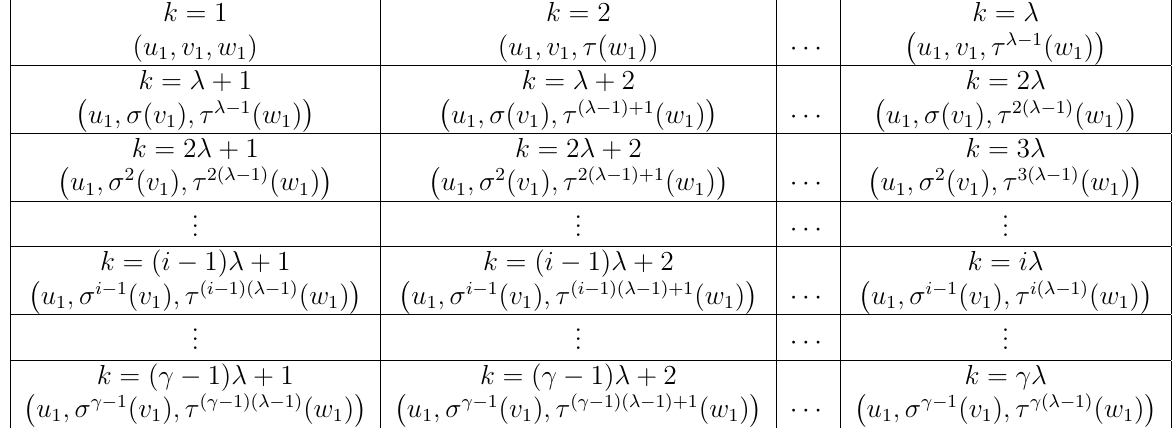
Table 2: First rows of The seed in the i th row and j th column of Table 2 is given